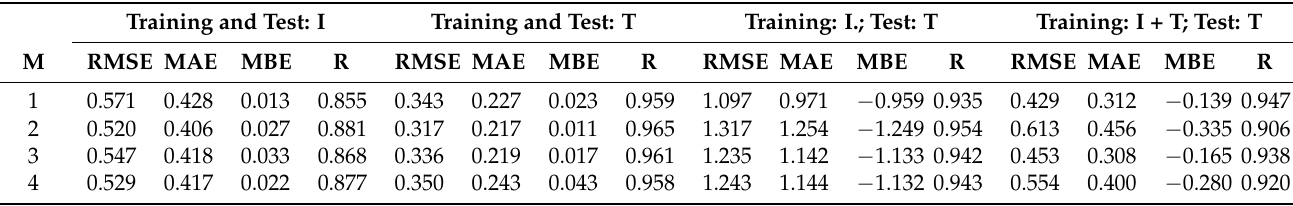
Table 4. Performance of the PC NN -PTFs estimating log-transformed soil hydraulic conductivity data (cm d − 1 ) across four modeling scenarios.